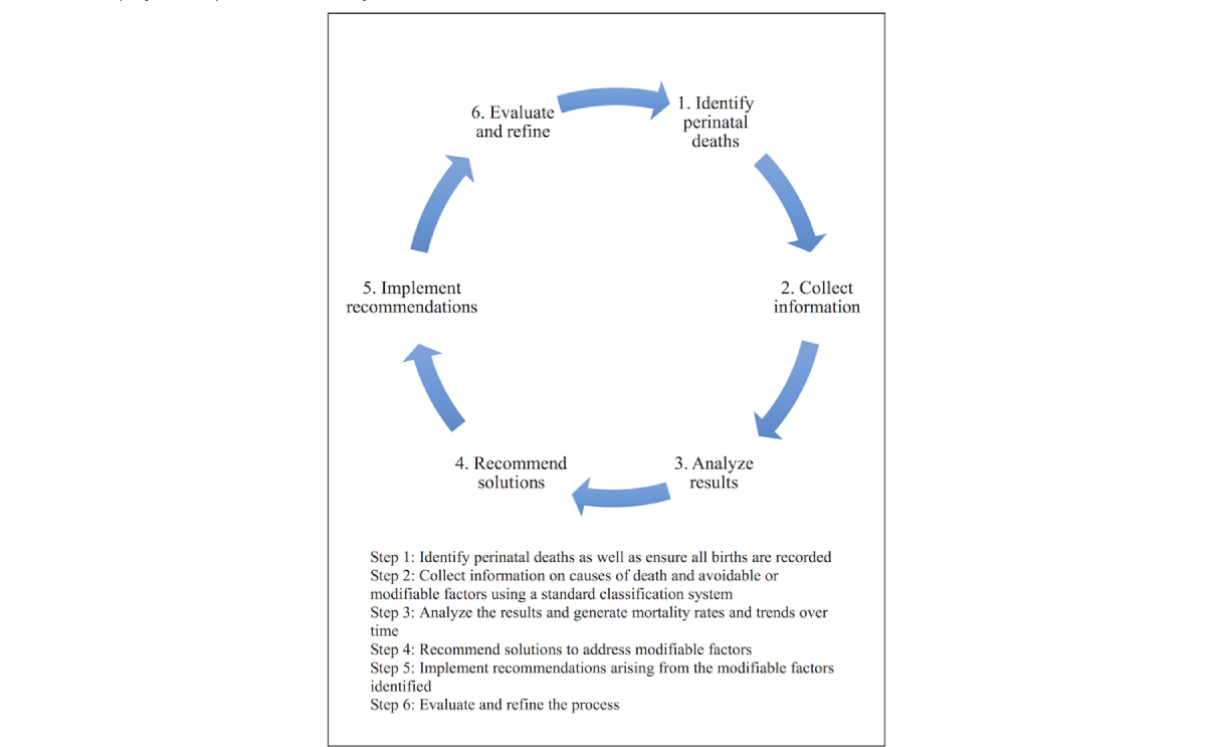
Figure 1. Six-step cycle for perinatal mortality